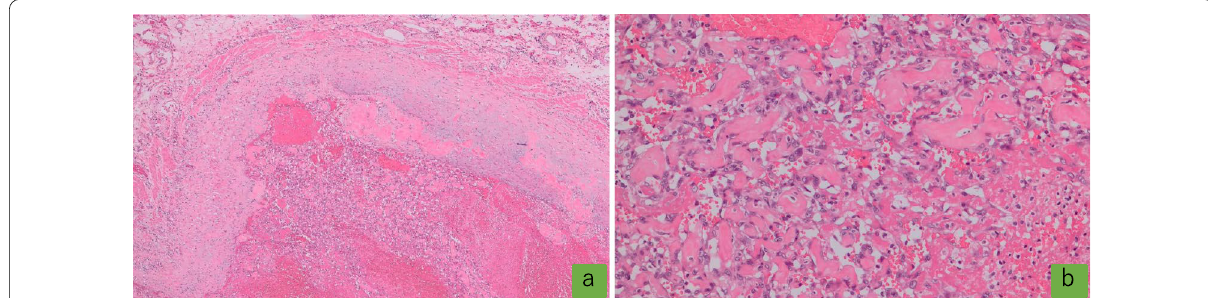
. b HE, 200 . The lesion was composed primarily of a complex network of × ×